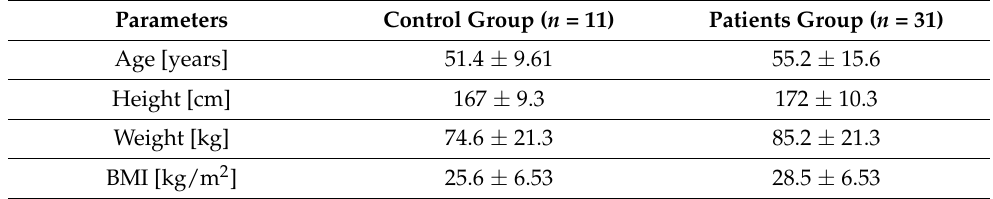
Table 2. Basal characteristic of the patients’ group before and after total treatment.